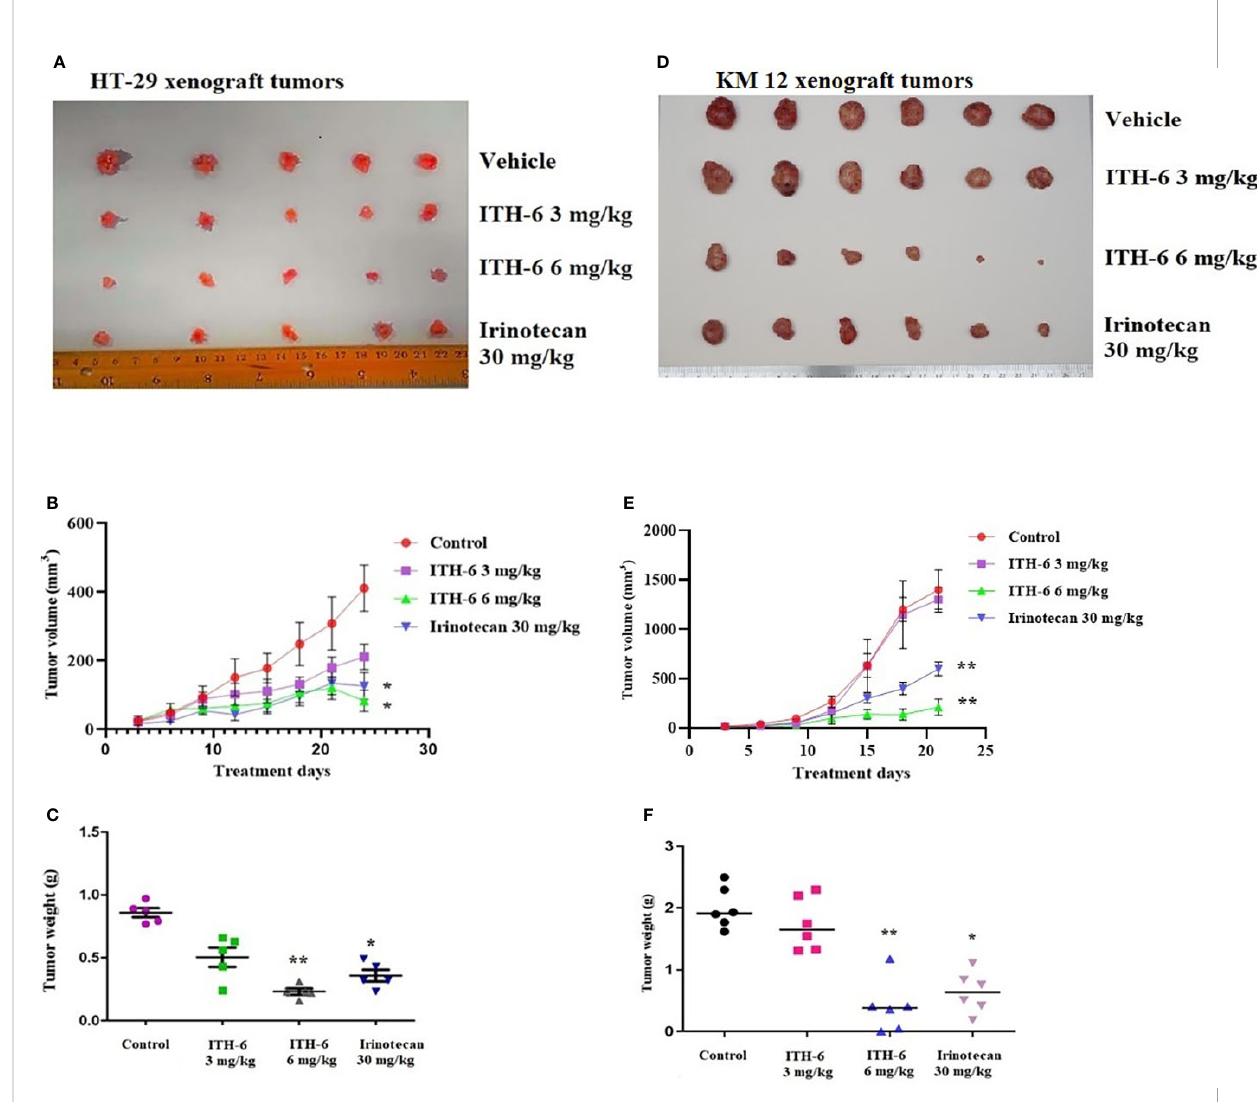
FIGURE 8 ITH-6 inhibits tumor growth, volume, and weight in xenograft mouse model. NCR nude mice were inoculated with subcutaneous implantation of HT-29 and KM 12 cells. During a 21-day treatment period, ITH-6 (6 mg/kg) signi fi cantly inhibited the growth, volume, and weight of (A – C) HT-29 and (D – F) KM 12 tumor xenografts compared with the vehicle control and irinotecan group. Values represent the median ± SD of six animals per group. Similar results were obtained in two independent experiments. * p <.05 and ** p <.01 compared with the control